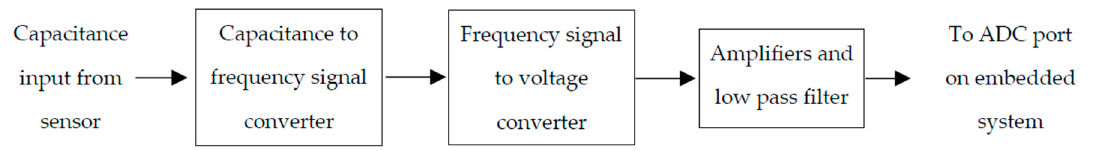
Figure 6. Signal processing scheme to register humidity fluctuations on an embedded system. Source: Authors.